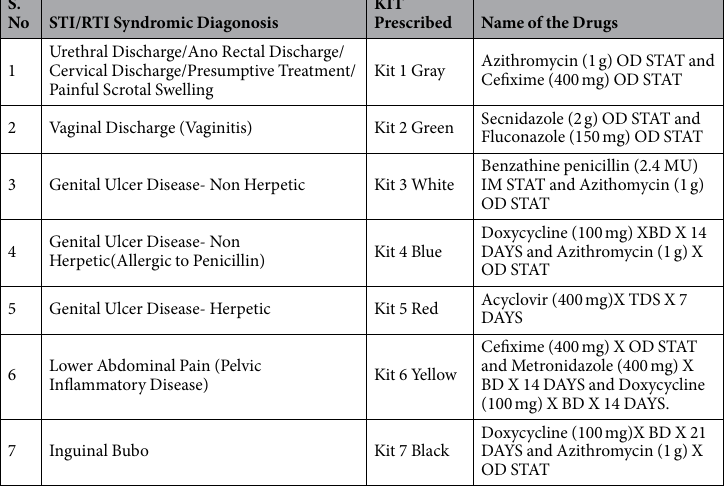
Table 2. Management and treatment guidelines for symptomatic patients through syndromic case